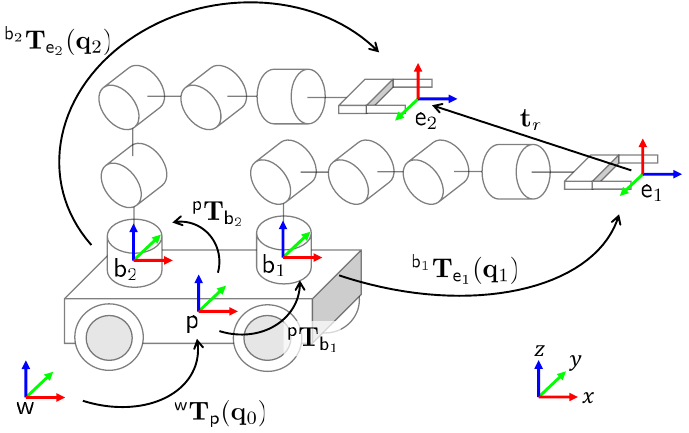
Figure 2. Kinematic chain of the mobile dual-arm system based on the KUKA ® Youbot ®